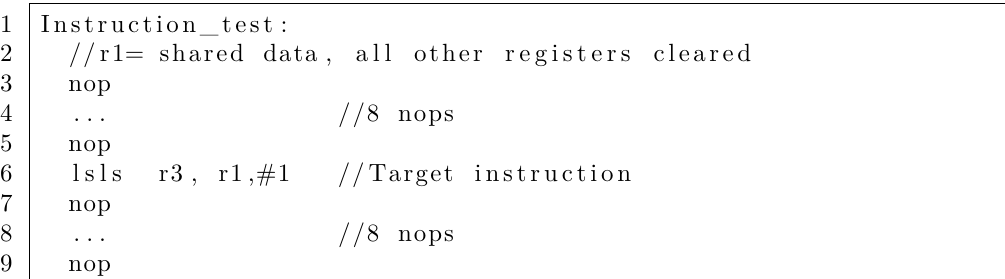
Figure 4: Instruction test code for Thumb-1 instruction